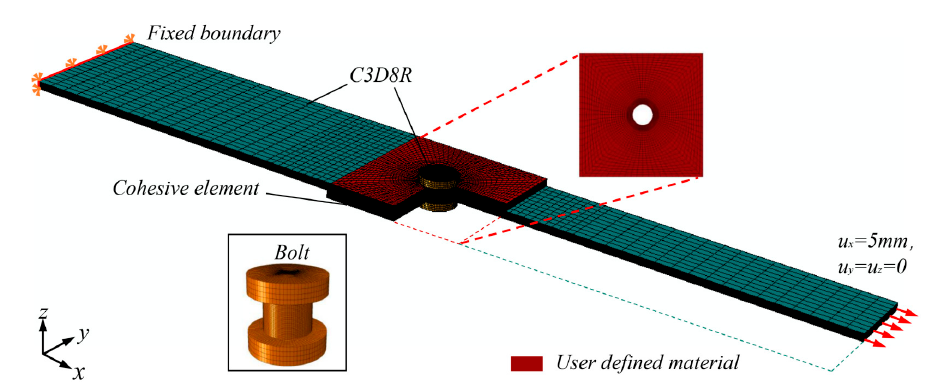
Figure 2. CFRP single ‐ lap finite element model.